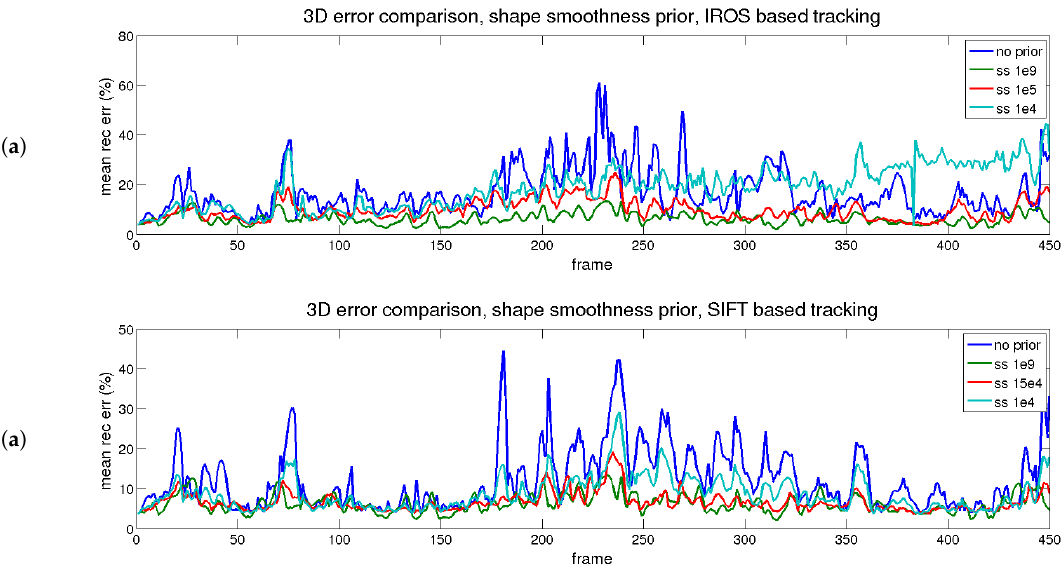
Figure 11. Rendered flag sequence: 3D reconstruction error over time with shape smoothness. Results are shown for two types of descriptors. ( a ) IROS; ( b )